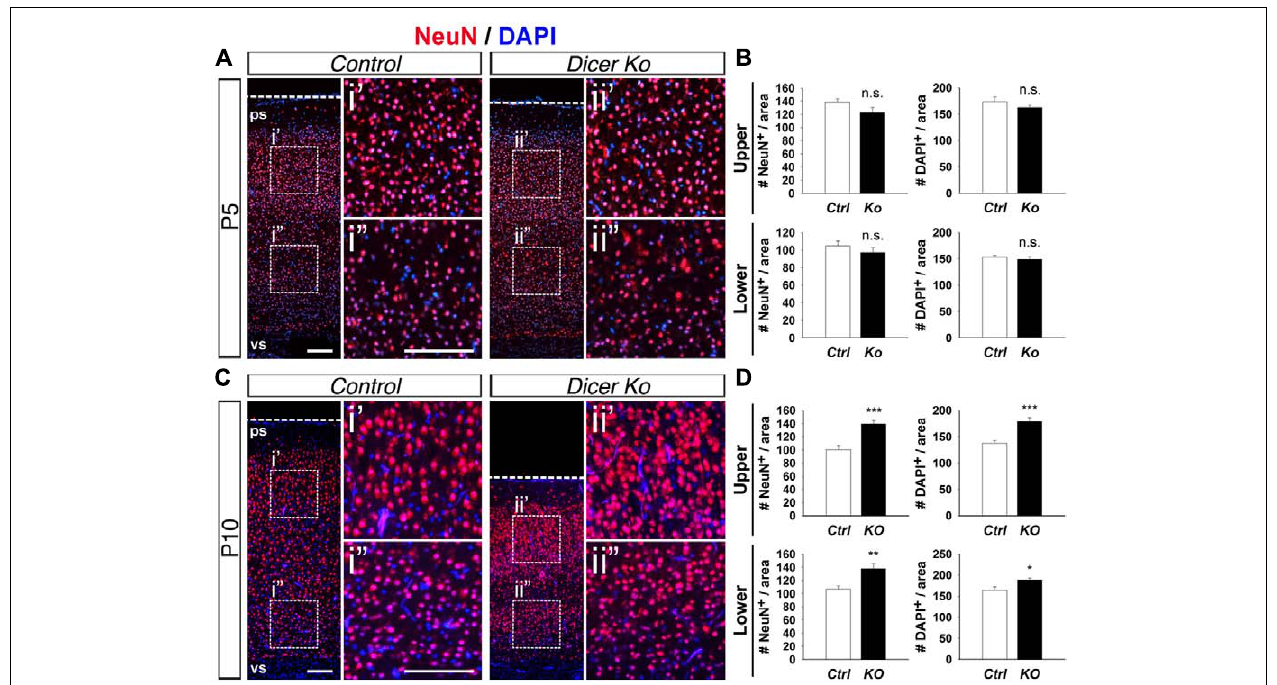
FIGURE 4 | Conditional Dicer ablation increases neuron and cell packing density within the cortex at P10. (A,B) Numbers of NeuN + and DAPI + cells were unaffected in the upper and lower regions of the cortical wall of P5 Nex-Cre-Dicer Ko ( Ko ) cortices compared to controls ( Ctrl ). (C,D) Numbers of NeuN + and DAPI + cells in the upper and lower regions of the cortical wall were significantly increased in P10 Dicer Ko cortices compared to controls.